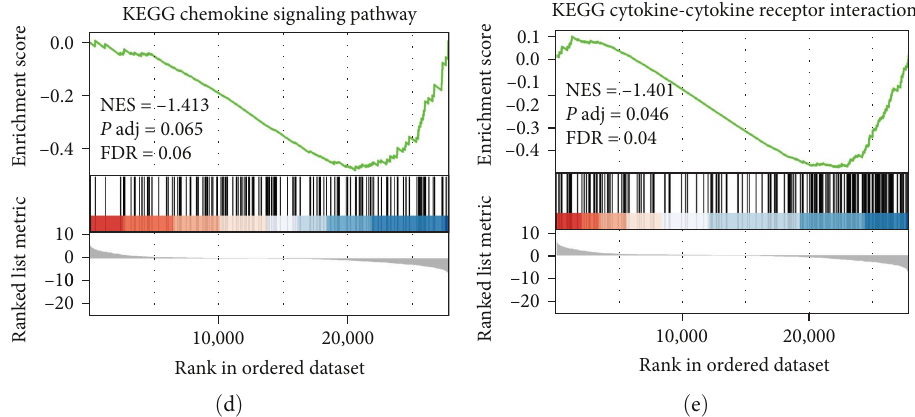
F IGURE 5: USP43 is associated with T cell activation and inhibits CD8 + T cell activation in PDAC based on tissue microarray: (a) IHC staining of 38 patients ’ tissue microarray showed the relationship between USP43 expression and CD8 expression; (b) correlation analysis of the expression of USP43 with CD4, CD8, CD68, CD163, and FOXP3 (Spearman correlation analysis); (c) utilizing PANC02 control and shUSP43 cell lines, we analyzed transcriptome of two cell lines to fi nd the enrichment of DEGs; (d) the correlation between USP43 and chemokine signaling pathway; (e) the correlation between USP43 and cytokine – cytokine receptor